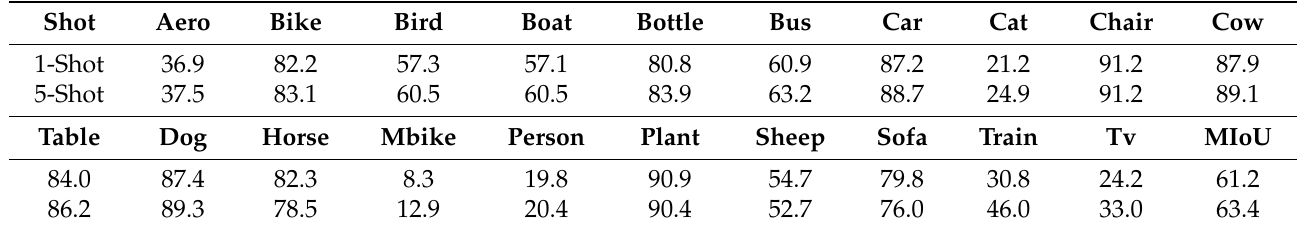
Table 2. Per-class mIoU results on PASCAL-5 i . The models are based on ResNet-50. Shot Aero